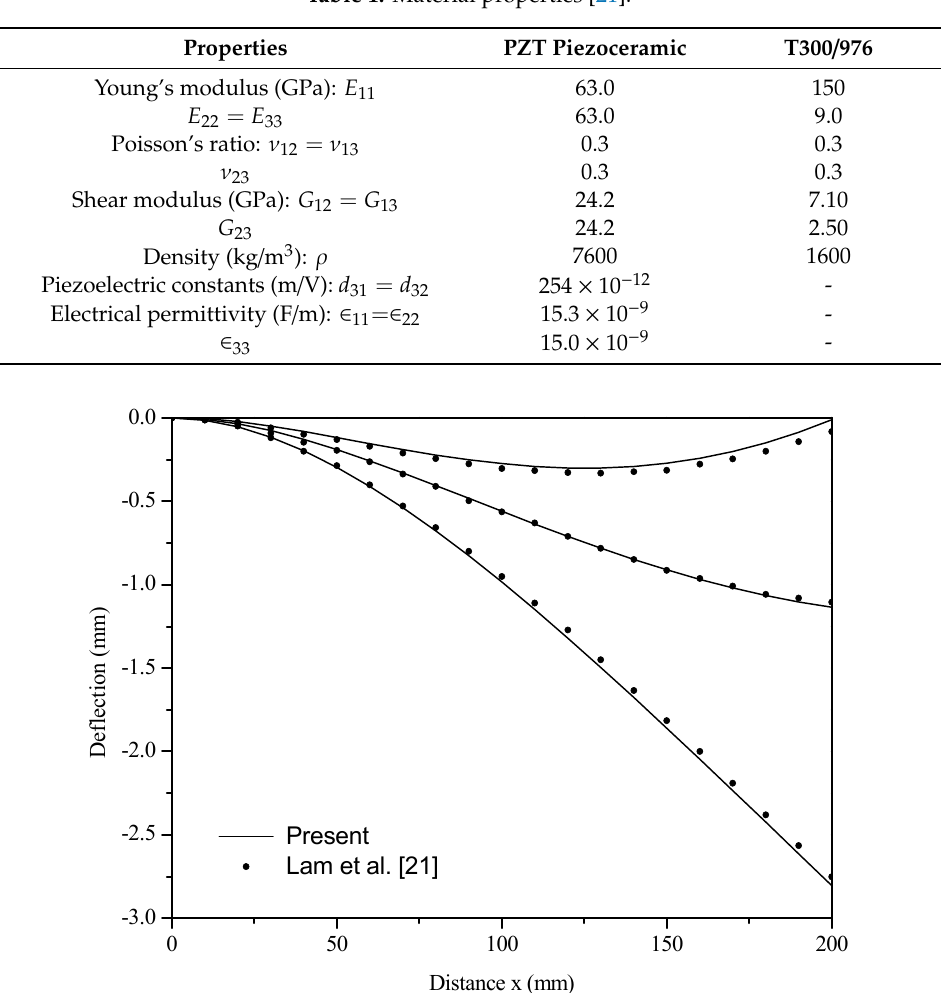
Figure 3. The centerline deflections with various input